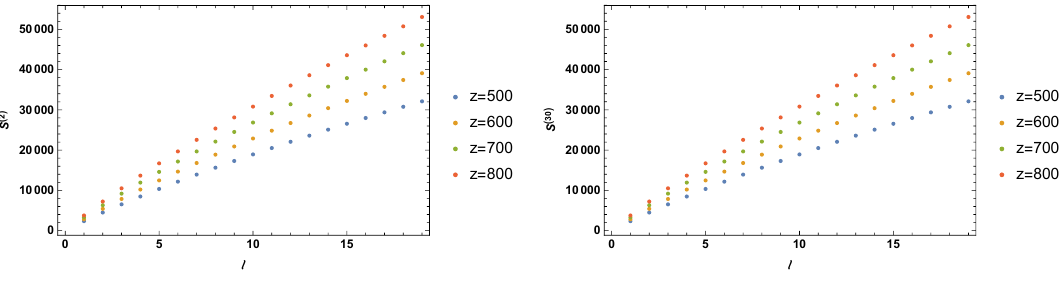
Figure 4 . Renyi entropy as a function of ‘ for large values of z with m = 0 and N = 20000.